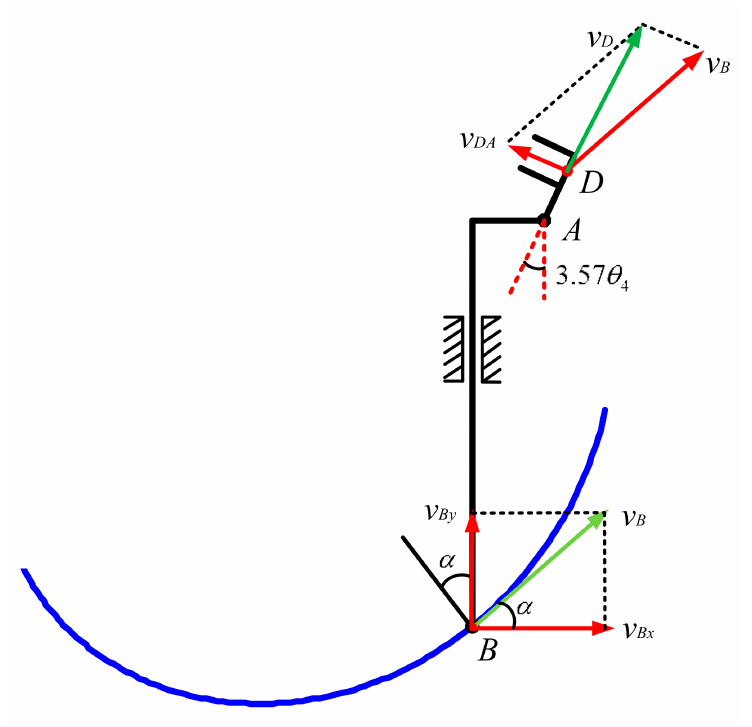
Figure 5. The velocity analysis for the cam